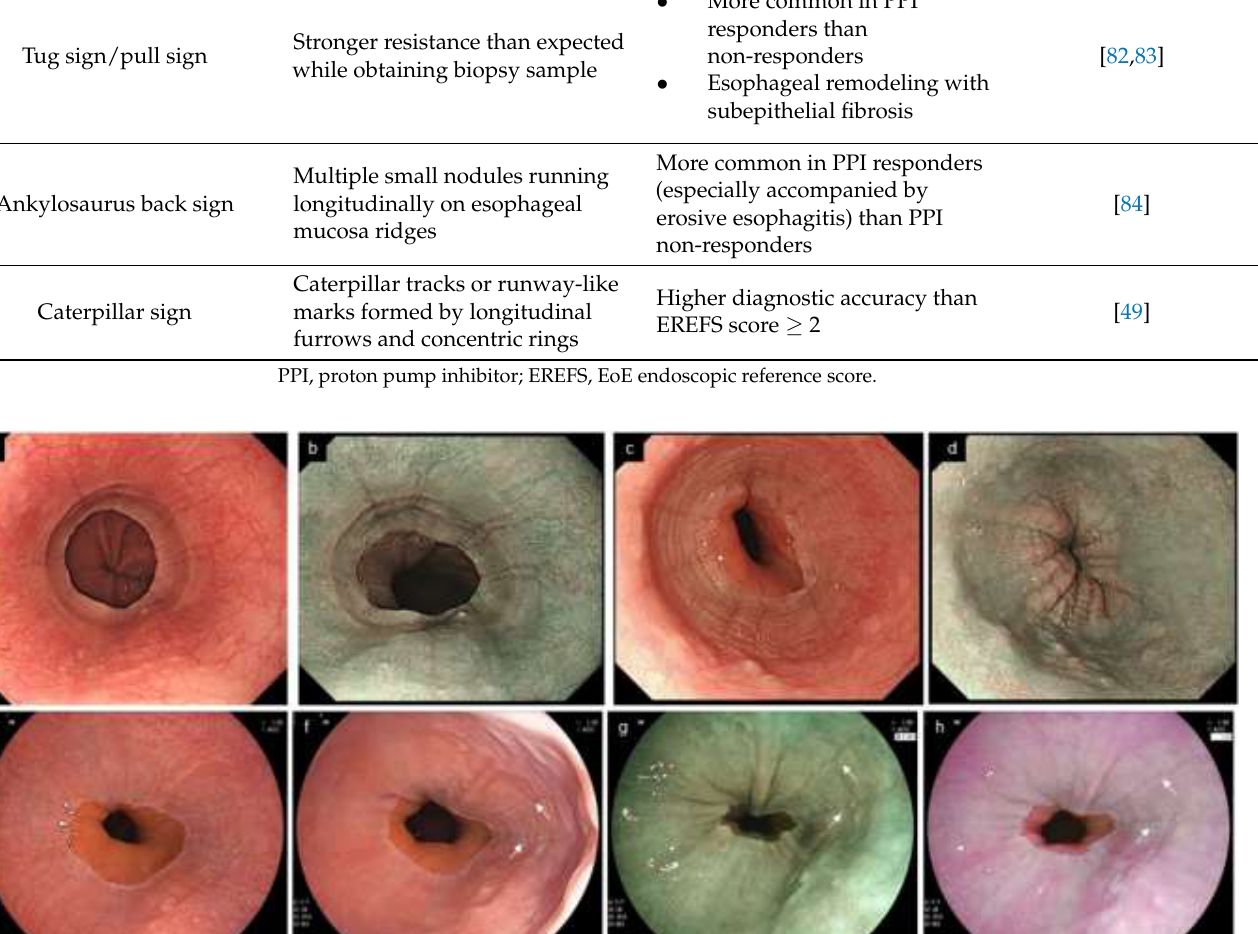
Figure 8. Localized EoE in the lower end of the esophagus. Endoscopic abnormalities are localized at a small area of 1 – 2 cm in the lower end of the esophagus. ( a , b ). Furrows and edema are present in the lower end of the esophagus (same patient, a , WLI; b , NBI). ( c , d ). Furrows, rings and edema in the lower end of the esophagus (same patient, c , WLI; d , NBI). ( e ). No abnormal findings appear to be found under full expansion of the esophageal lumen (WLI). ( f – h ). Reducing the esophageal wall tension increases the visibility of furrows (arrow) and edema. Dynamic observation